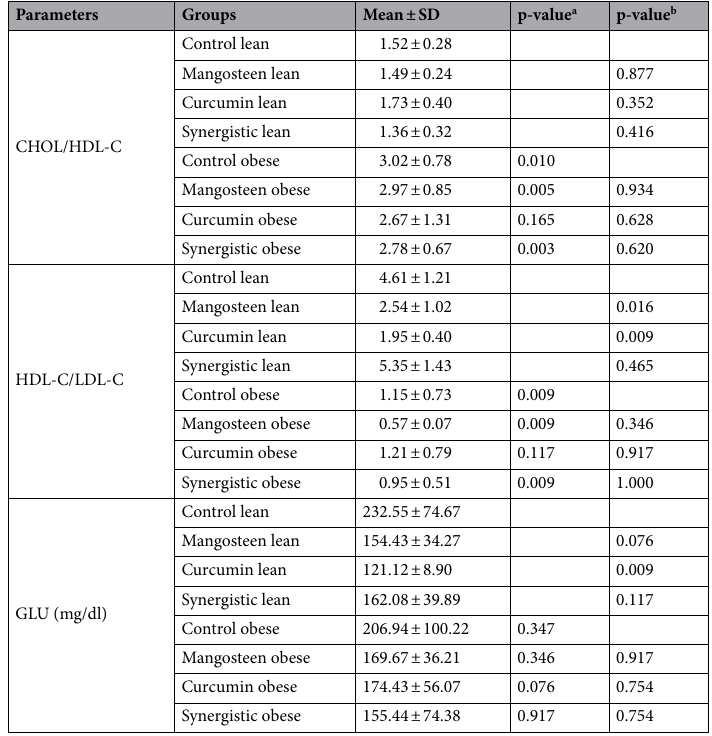
Table 4. Independent and synergistic effects of curcumin and mangosteen extract on cardiovascular risk factors in lean and HFD-induced obese rats. a Significant difference between normal weight and obese rats in each group (control, mangosteen, curcumin, and synergistic). b Significant difference between each group and respective normal weight or obese control groups.